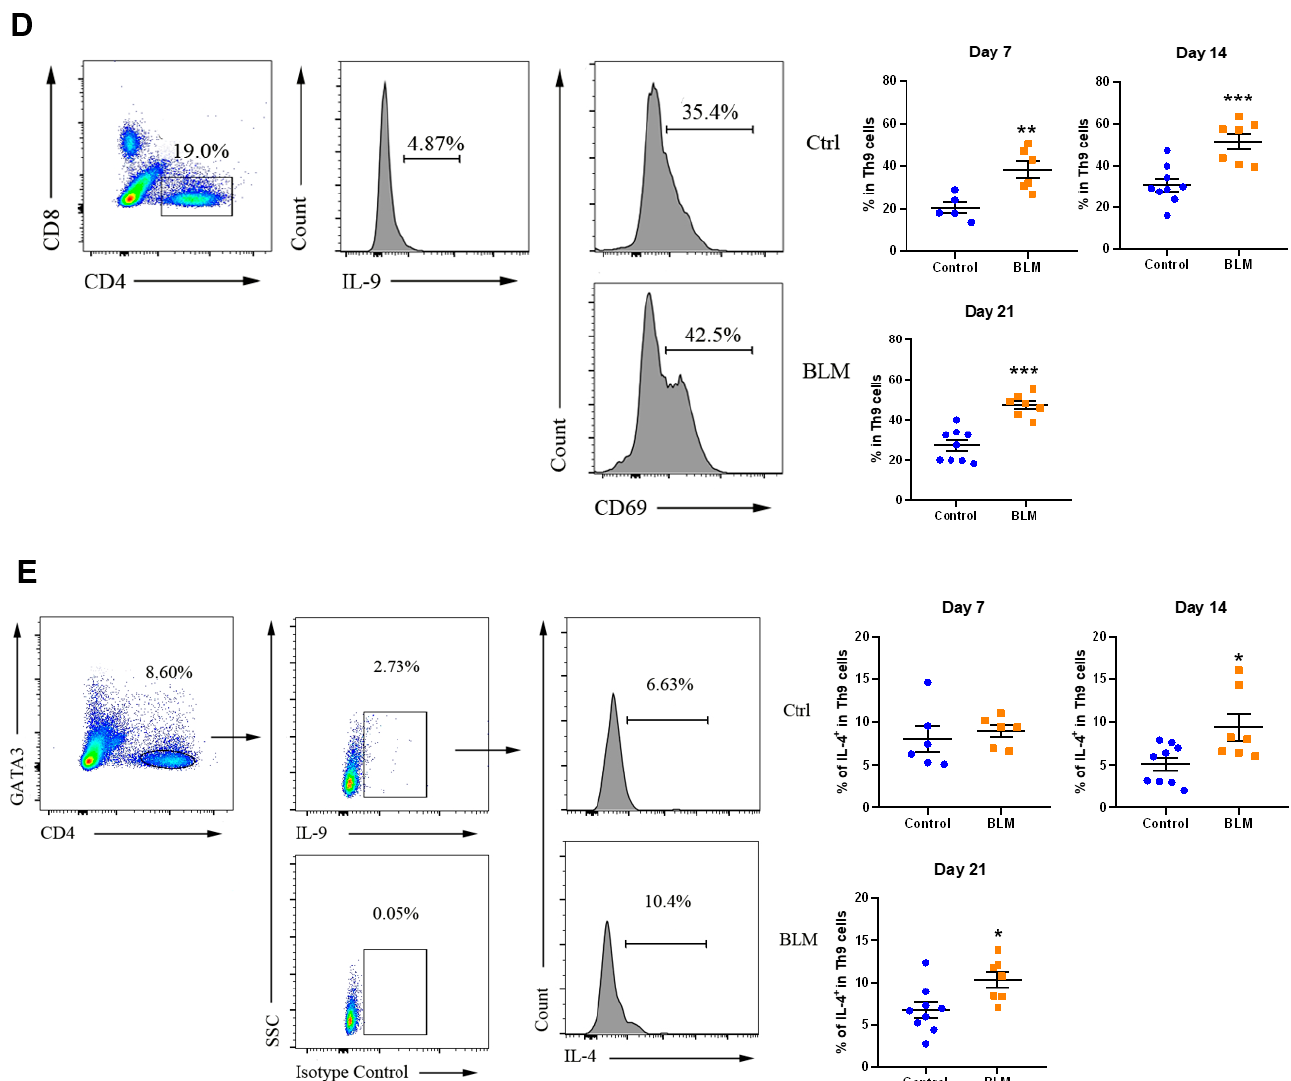
Figure 2. Increased Th9 cell differentiation and activation in the lung of bleomycin (BLM)-induced pulmonary fibrosis mice. ( A ) Representative pseudo-color plot showing proportion of Th9 cells to CD4 + T cells in the lungs of BLM mice and control mice (CD4 + IL-9 + T cells were defined as Th9 cells). ( B ) Proportion of Th9 cells in the lung tissue of BLM mice and control mice (n = 6 to 9) at the indicated time points calculated by flow cytometry. ( C ) Quantitative PCR analysis of PU.1 and Irf4 in the BALF cells of BLM mice and control mice at the indicated time points. ( D ) Activation of Th9 cells in the lung of BLM mice and control mice at the indicated time points. ( E ) Increased expression of IL-4 in Th9 cells (CD4 + IL-9 + IL-4 + T cells) in the lung of BLM mice. P values were determined by two-sided Student’s t -test. BALF, bronchoalveolar lavage fluid. * p < 0.05, ** p < 0.01, *** p < 0.001.